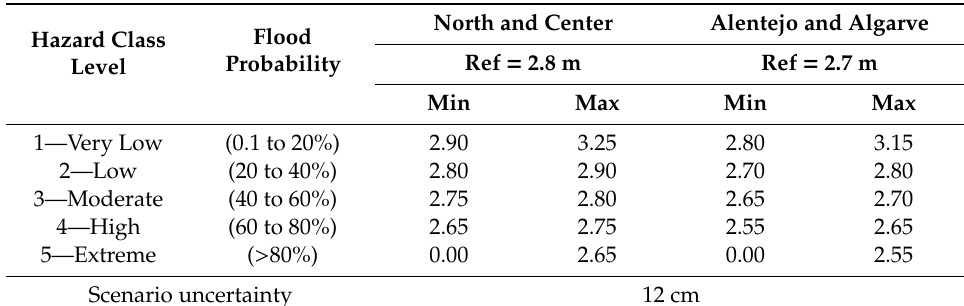
Table 5. Intervals for each EFHI class and respective probability for the 2050 SLR scenario with 100-year RP storm surge for each geographic zone, relative to the central reference flooding elevation level (the Ref value corresponds to the EFL central estimation).